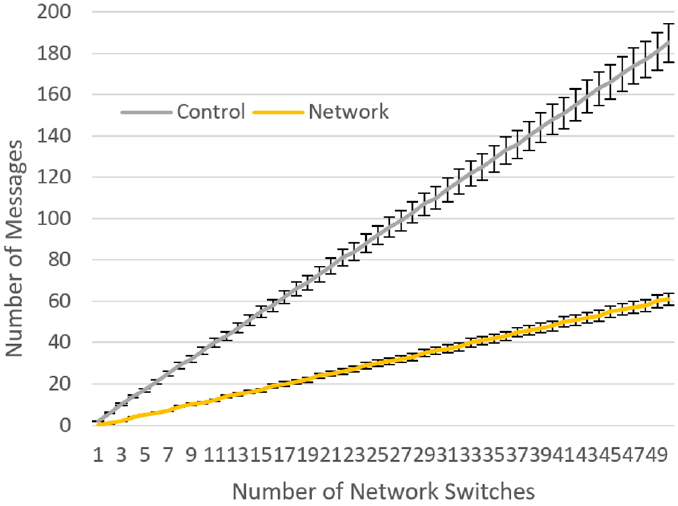
Figure 6. Average reduction in the number of messages caused by the operation of a proactive controller for each new data flow.